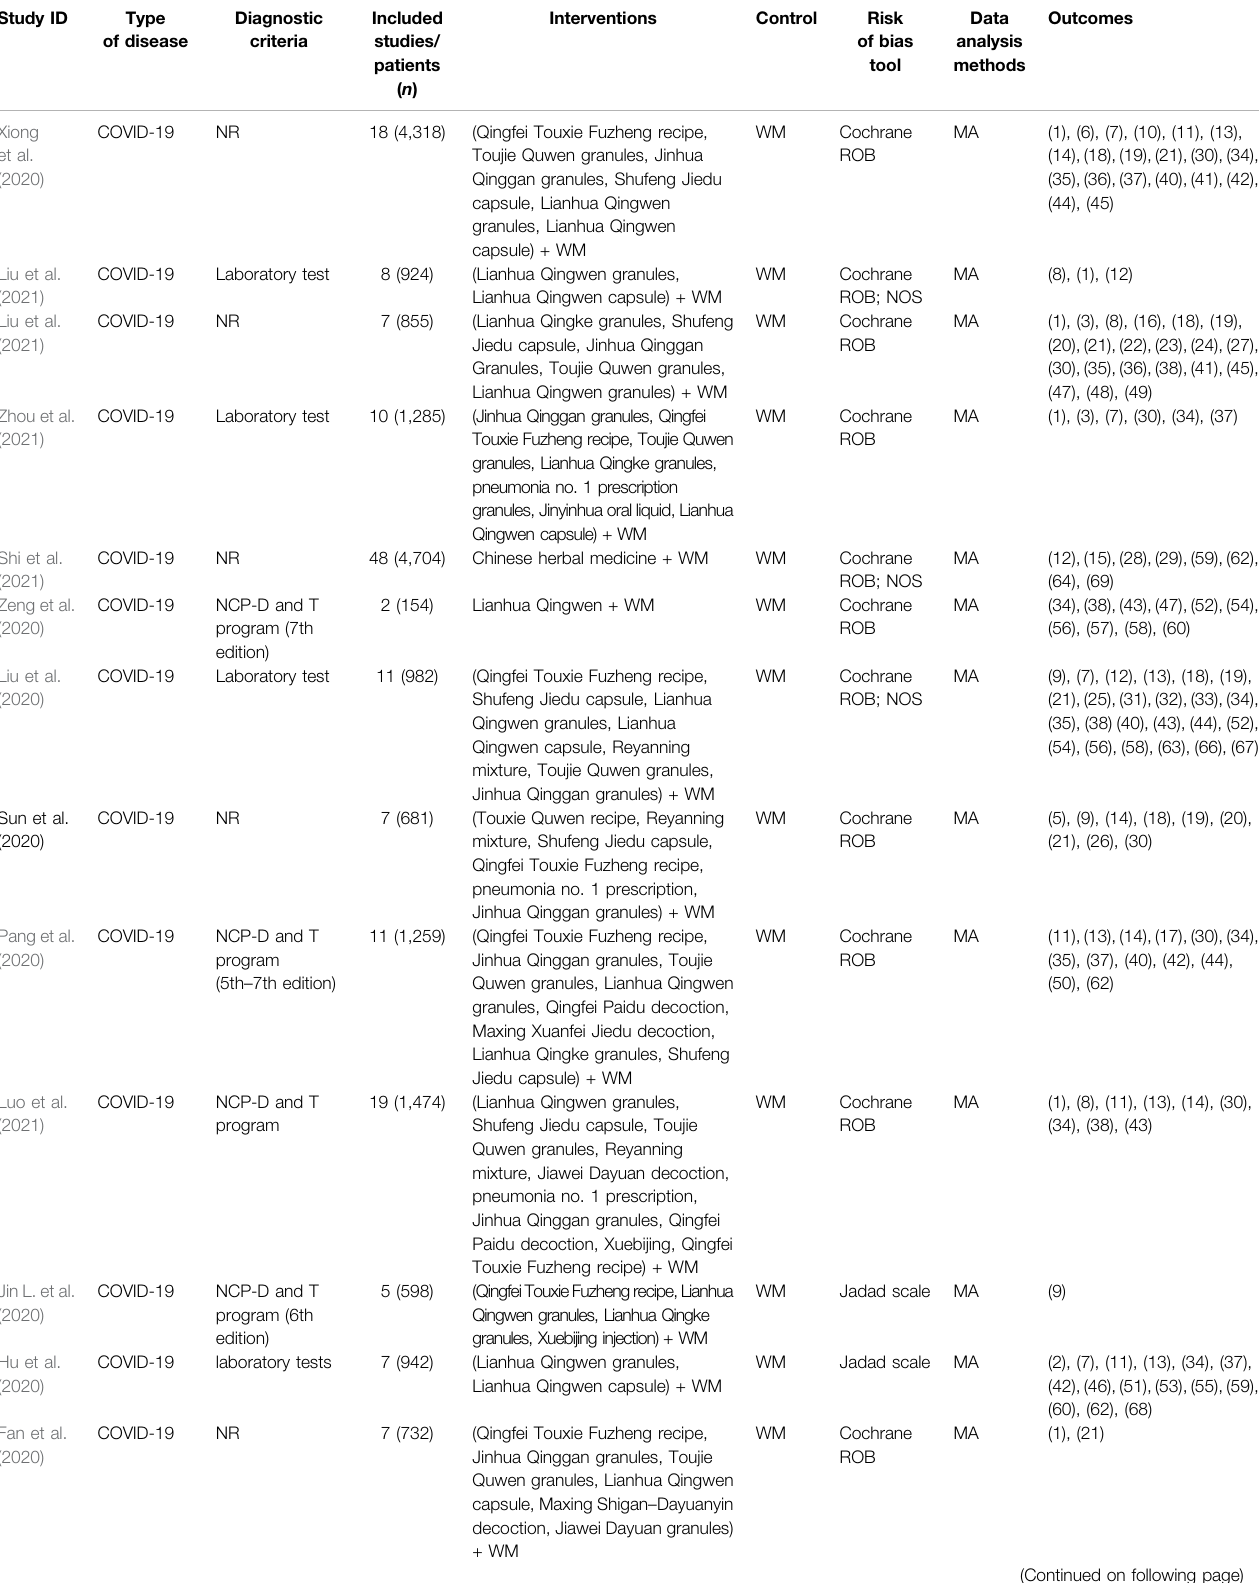
Interventions Control Risk